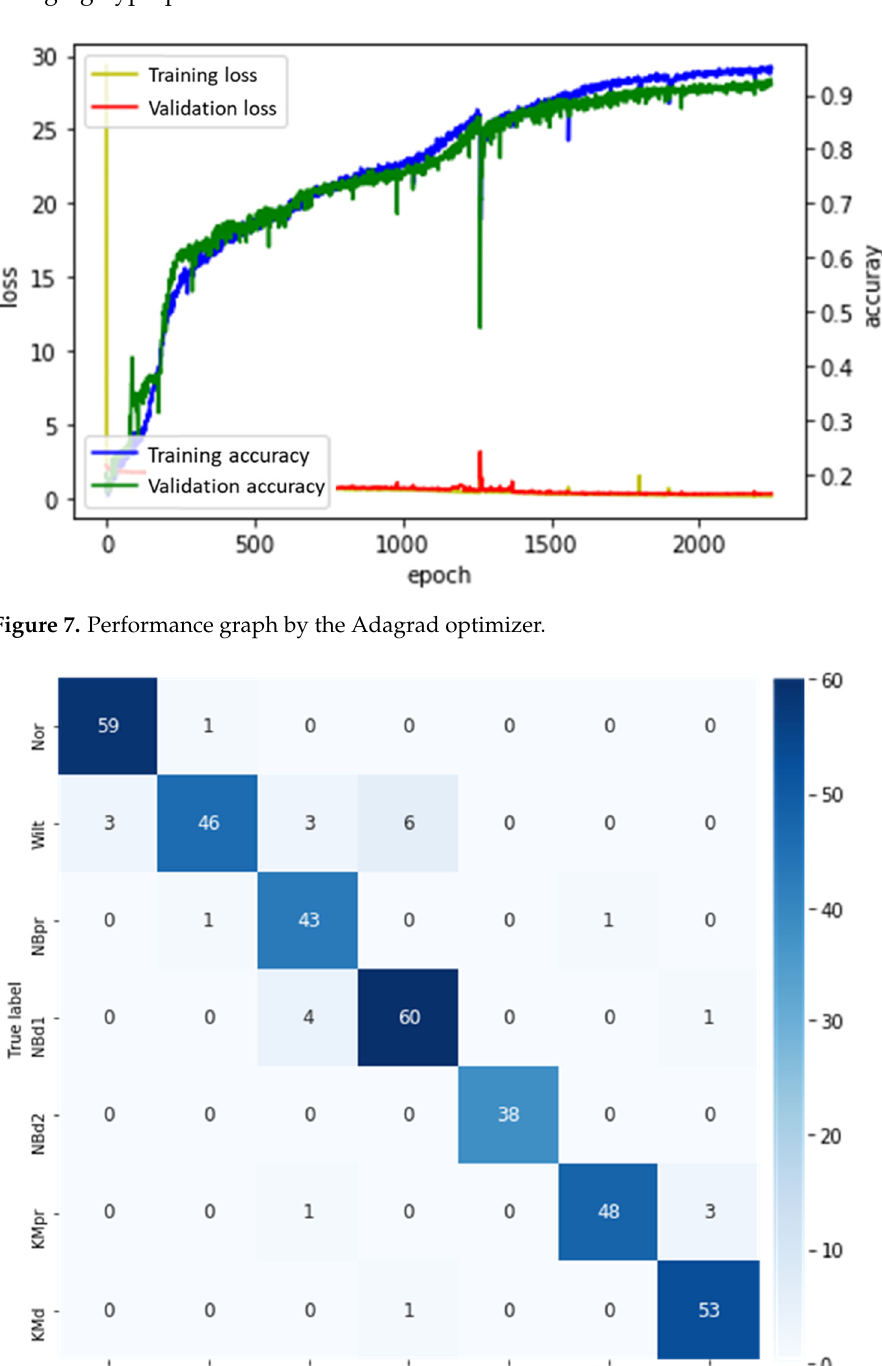
Figure 9. Performance graph by the RMSProp optimizer. Figure 10 shows the test set evaluation results of the optimal model for the RMSProp optimizer. Since the classification performance was 95.70%, a confusion matrix with good results was yielded. Compared to the results of Adagrad, which had a relatively large misclassification in three classes, the number of classes was the same, but the overall pre- diction error was greatly improved. However, the NBpr class showed poor performance